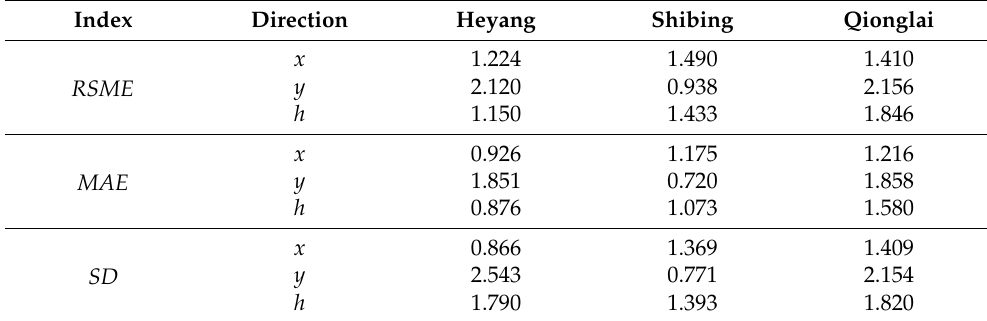
Table 4. Accuracy assessment of DSMs results in RMSE , MAE , and SD (m) of the three experimental areas. Index Direction Heyang Shibing Qionglai x RSME